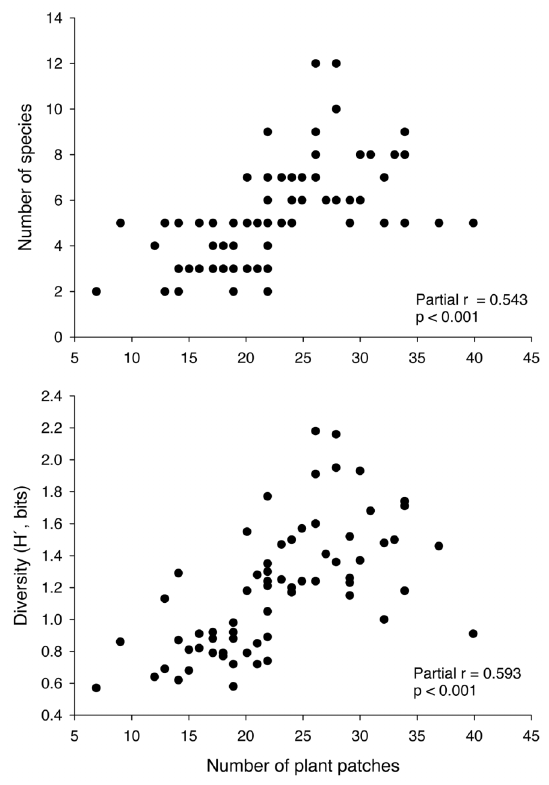
Fig. 3. Relationships between the number of discrete plant patch- es and the richness and diversity of perennial vascular plants in semi-arid steppes of SE Spain. Results of partial correlation anal- yses, where the effect of plant cover is controlled, are shown in the lower right margin of each graph. Adapted from data summa- rized in Maestre and Cortina